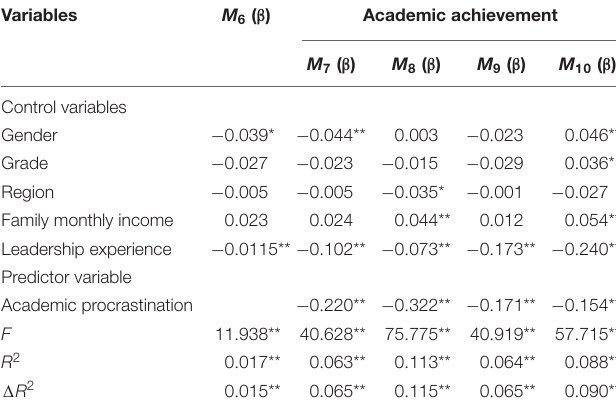
TABLE 4 | Influence of academic procrastination on academic